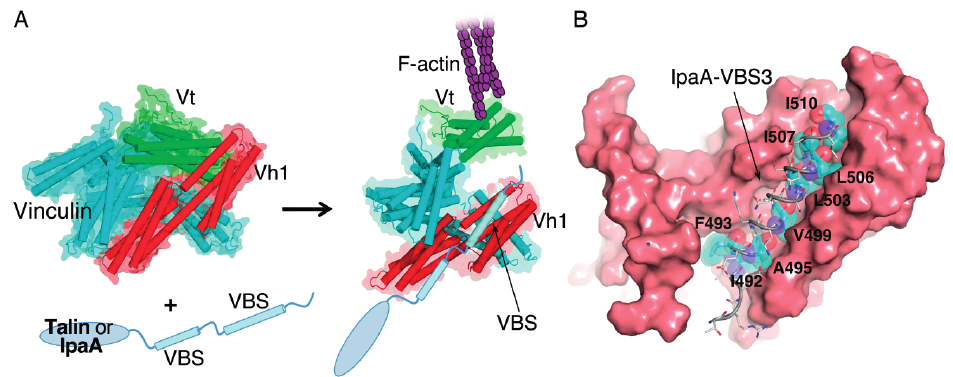
Figure 2. Vinculin activation by IpaA or talin. ( A ) Inactive vinculin is in a closed conformation through the Vh1:Vt interaction ( left ). IpaA or talin binds to Vh1 of vinculin through their vinculin-binding sites (VBSs), inducing helical bundle conversion of Vh1 ( right ). The structural change causes dissociation of the Vh1:Vt interaction, which triggers F-actin binding to Vt. Activated vinculin ( right ) is modeled from an inactive vinculin structure ( left ) (PDB entry: 1TR2). The schematic model shows only two VBSs, although talin has 11 VBSs [54]; ( B ) The crystal structure of IpaA-VBS3/vinculin complex (PDB entry: 3RF3) is shown as a representative example if the VBS/vinculin interaction. The hydrophobic residues of VBS3 that are involved in the interaction with vinculin are shown as cyan van der Waals spheres with residue labels. Vinculin is shown as a surface